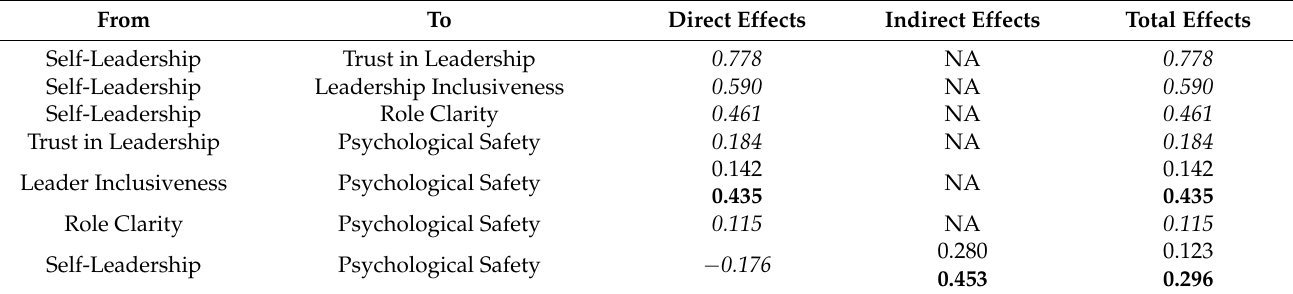
Table Notes: When path differences exist between India and the USA, normal text denotes paths in India and bold text denotes paths in the USA. Paths appear in italics when no significant differences exist between nations. To provide a quick summary of our results, the Table 7 gives a restatement of our hypotheses and research questions along with our study